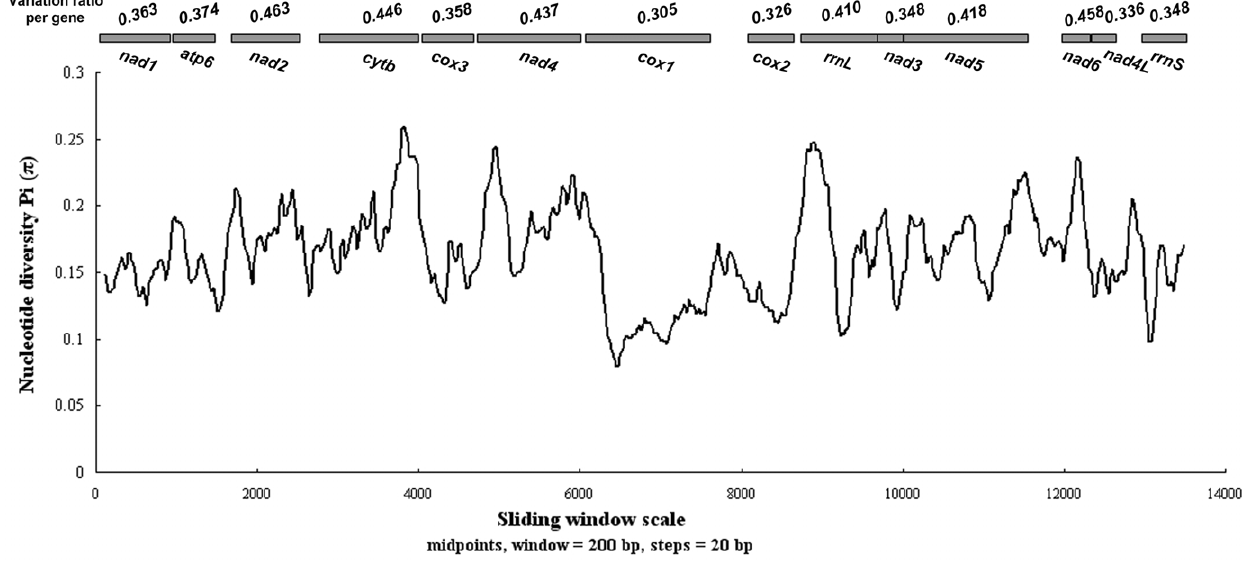
Figure 4. Sliding window analysis of the alignment of complete mtDNAs of 11 species of Ascaridida. The black line shows the value of nucleotide diversity Pi ( p ) in a sliding window analysis of window size 200 bp with step size 20, and the value is inserted at its mid-point. Gene boundaries are indicated with a variation ratio per gene.